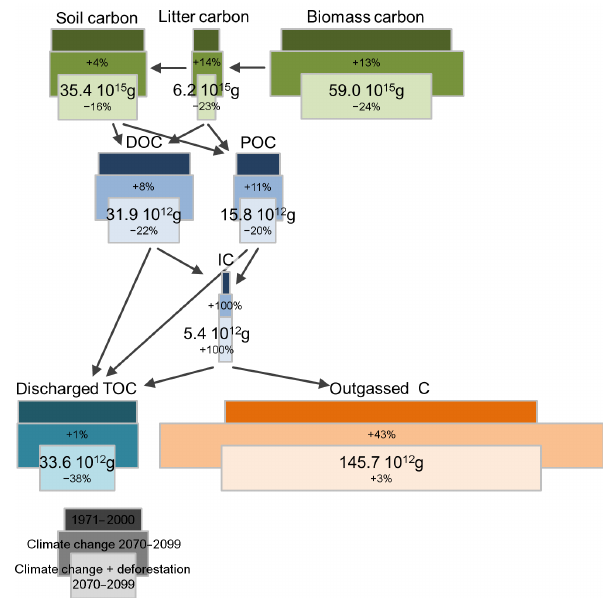
Figure 4. Averaged annual amounts and change in the basin carbon budget due to climate change and deforestation. Dark boxes indi- cate the amount of carbon during the reference period (1971–2000), intermediate boxes during the future period (2070–2099) under cli- mate change only (Langerwisch et al., 2016), light boxes during the future period under the forcing of climate change and deforesta- tion (BAU) together (average over all SRES scenarios and GCMs). Amount is given for future period with relative change compared to reference. Arrows indicate the direction of carbon